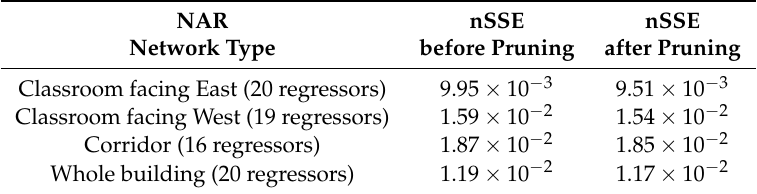
Table 1. Validation error (nSSE) before and after OBS